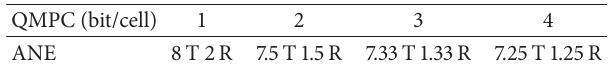
Table 4: The relation between the average number of elements required in order to memorize 1bit (ANE) and the quantity memorized per cell (QMPC).